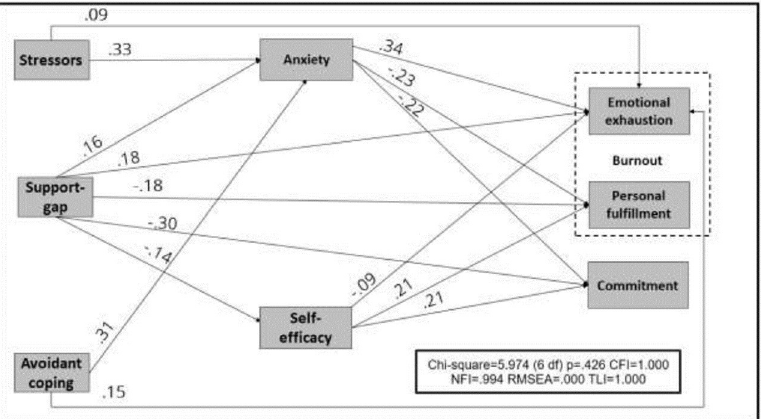
Fig 2. A structural equation model (SEM) analysis of the effect of avoidant-coping, support-gap, stressors (total), self-efficacy, and state anxiety on professional burnout (comprised of emotional exhaustion and personal fulfillment) and on commitment to